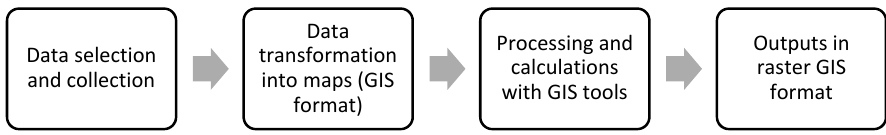
Figure 2. Schematic overview of the GIS approach.